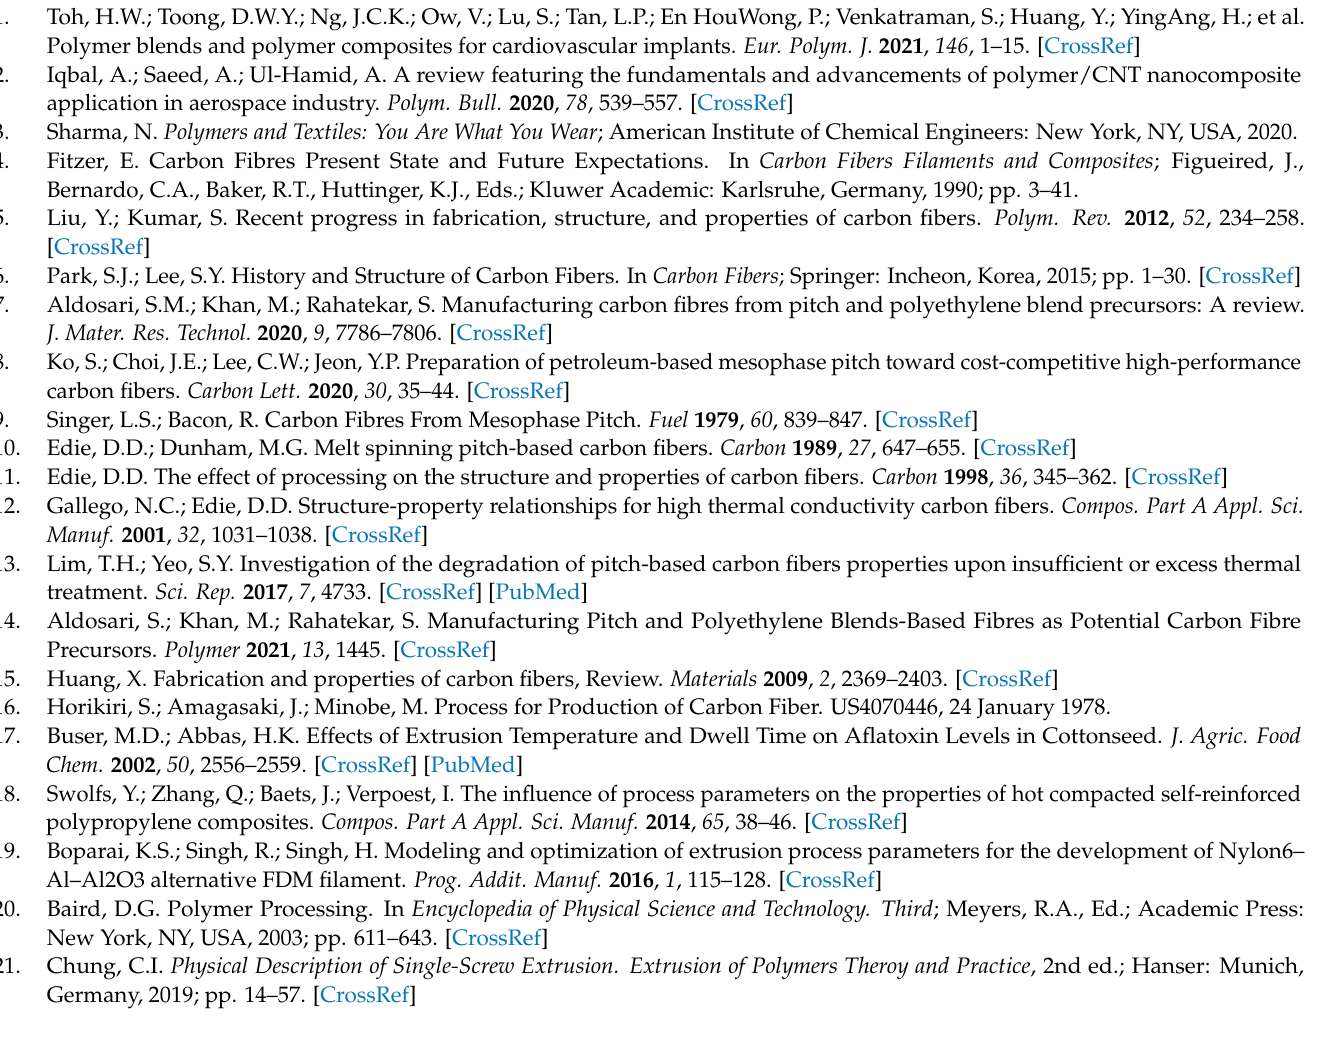
Figure A2. Increase in extrusion dwell time in 20 wt% LLDPE/pitch blend Figure A2. Graphical abstract.